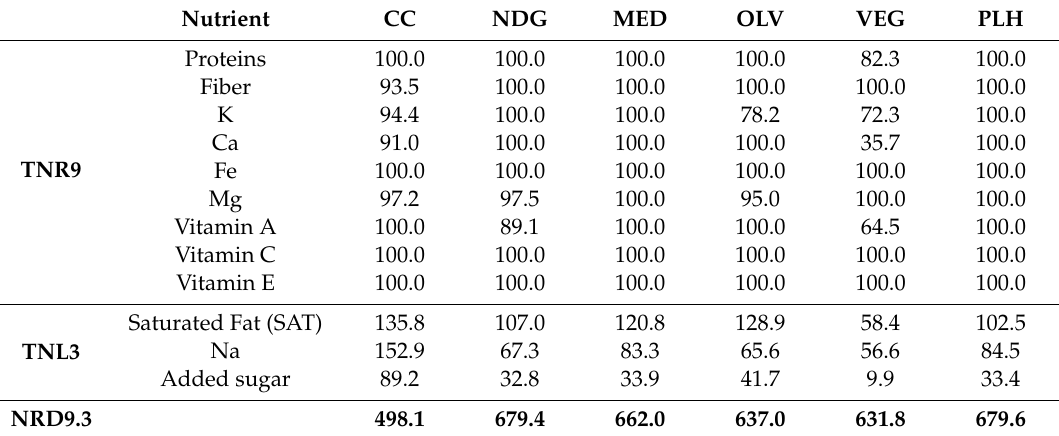
Table A1. TNR9, TNÑ3, and NRD9.3 of the pre-defined diets.